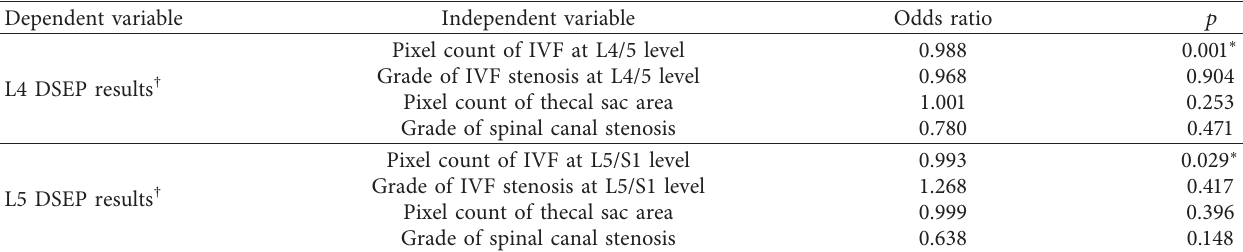
Table 3: Logistic regression of lumbar IVF and spinal canal stenosis with DSEP findings.